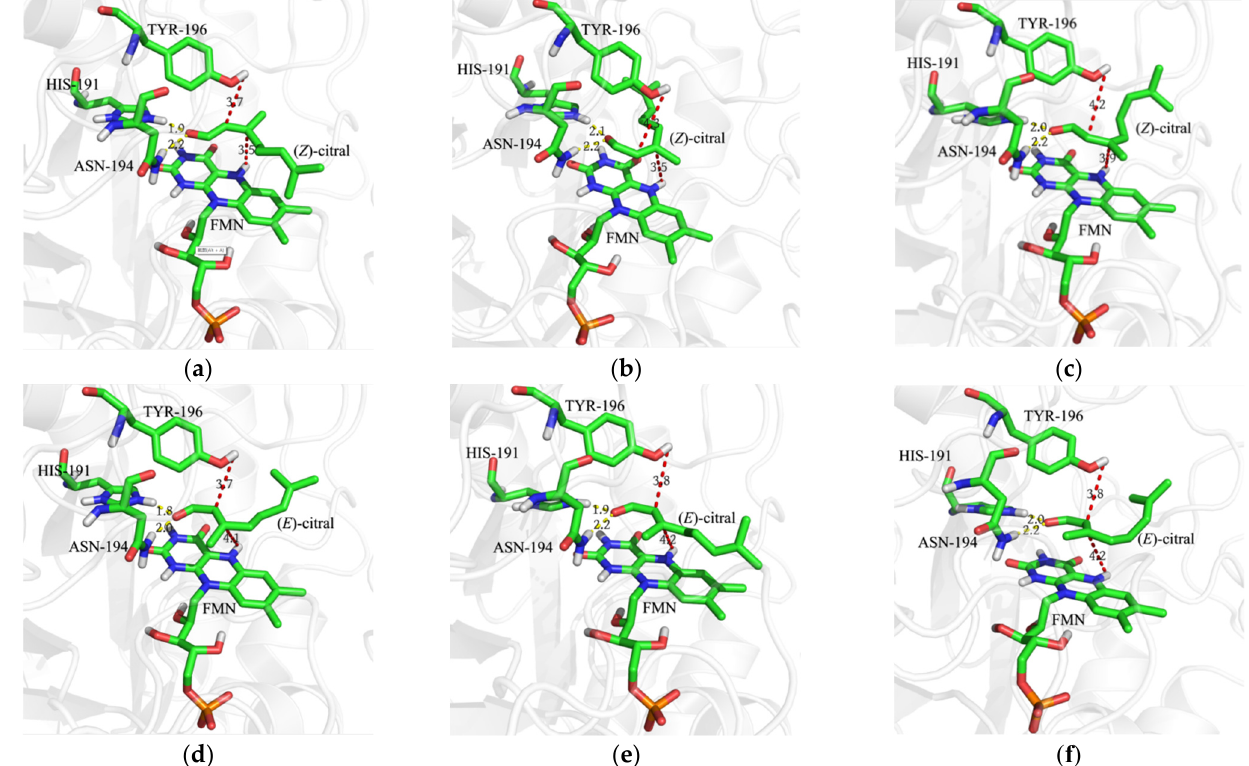
Figure 1. The binding modes of citral isomers in OYE3 and its variant S296F and W116G leading to either ( R )- or (S)- citronellal. ( a ) OYE3 and ( Z )-citral; ( b ) W116A and ( Z )-citral, flipped binding orientation; ( c ) S296F and ( Z )-citral, flipped binding orientation; ( d ) OYE3 and ( E )-citral; ( e ) W116A and ( E )-citral, preserved binding orientation; ( f ) S296F and ( E )-citral, preserved binding orientation. Green, carbon atom; blue, nitrogen atom; tangerine, oxygen atom; white, hydrogen atom; orange, phosphorus atom.